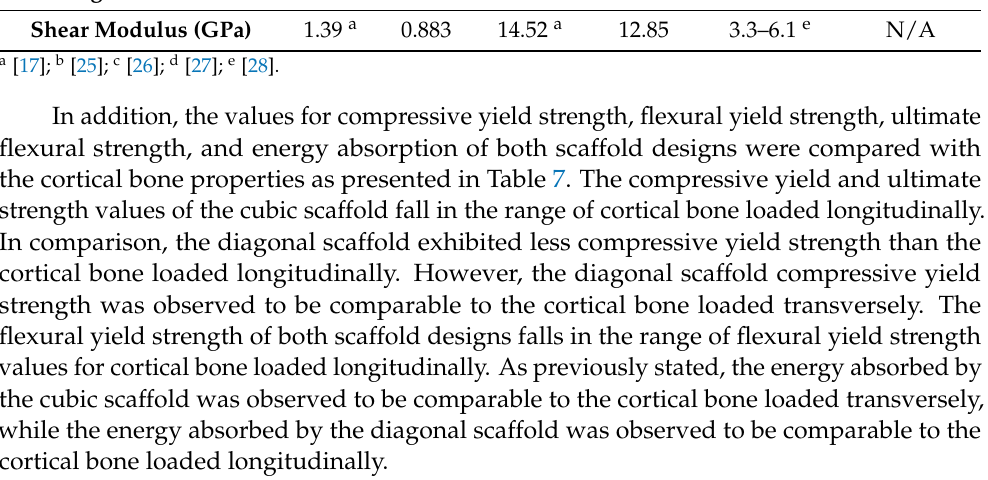
Cortical Bone Cubic Diagonal Scaffold Scaffold